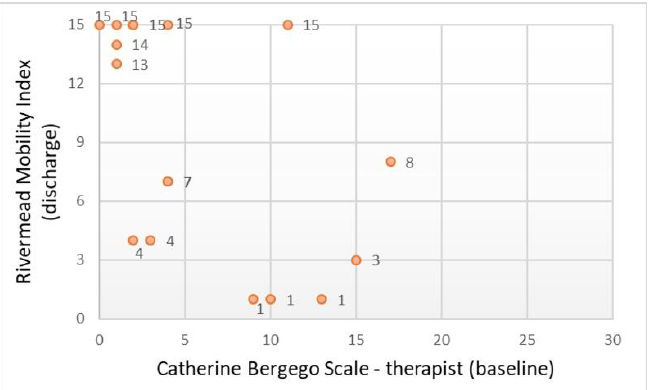
Figure 6. Scatter plot showing the relationship between the behavioral scale and daily mobility ( n =